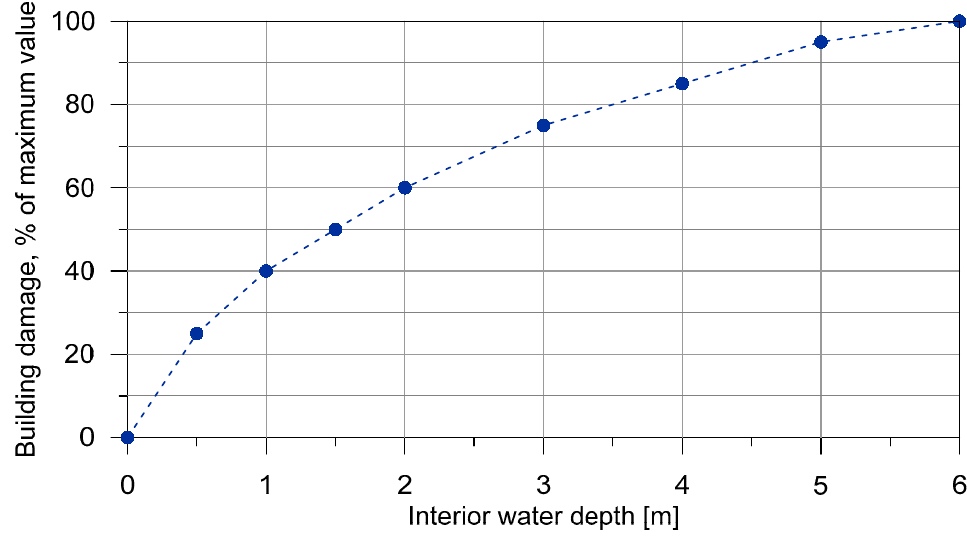
Figure 5. Depth-damage function for residential buildings in the Tamnava watershed.